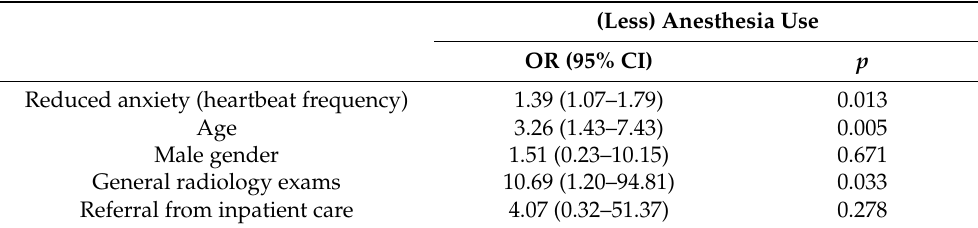
Table 4. The odds of (less) anesthesia use for reduced anxiety across groups (“Sim” and “PCC + Sim”), adjusting for other possible factors ( N =